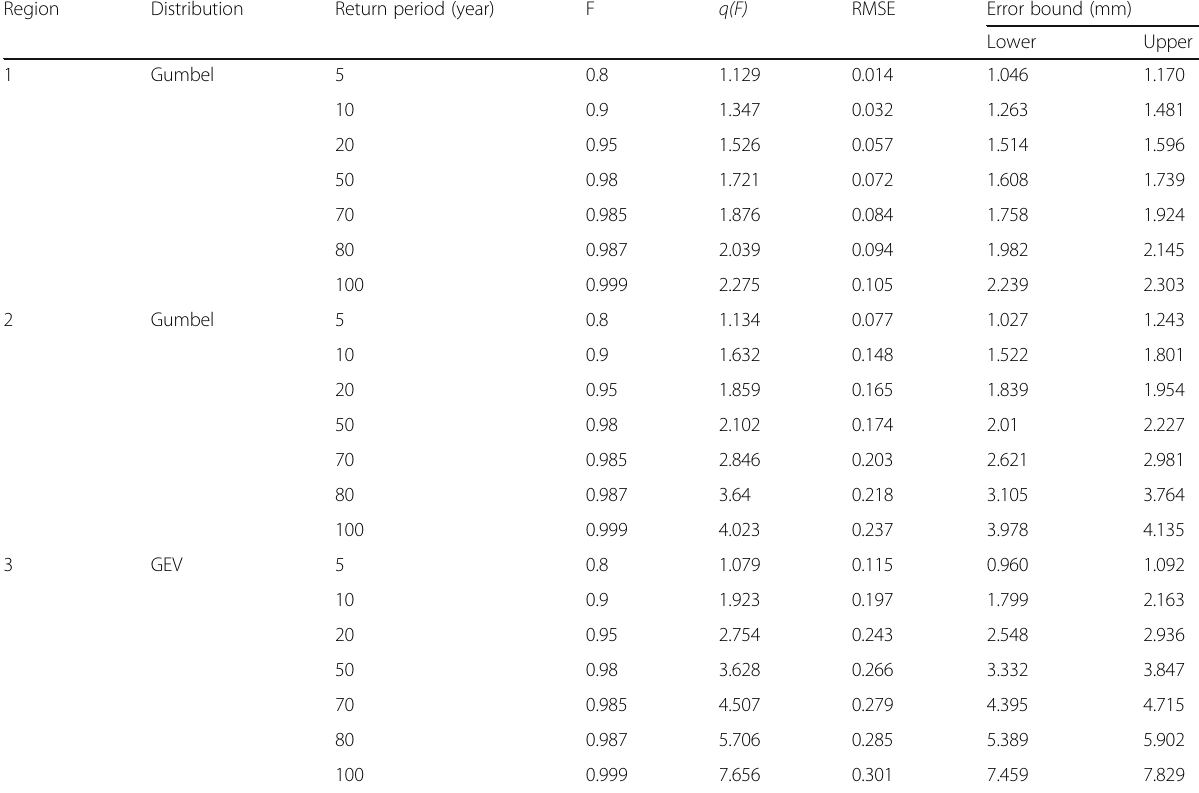
Table 4 Simulation results of estimated regional quantiles, RMSE and corresponding 90% error bounds values Region Distribution